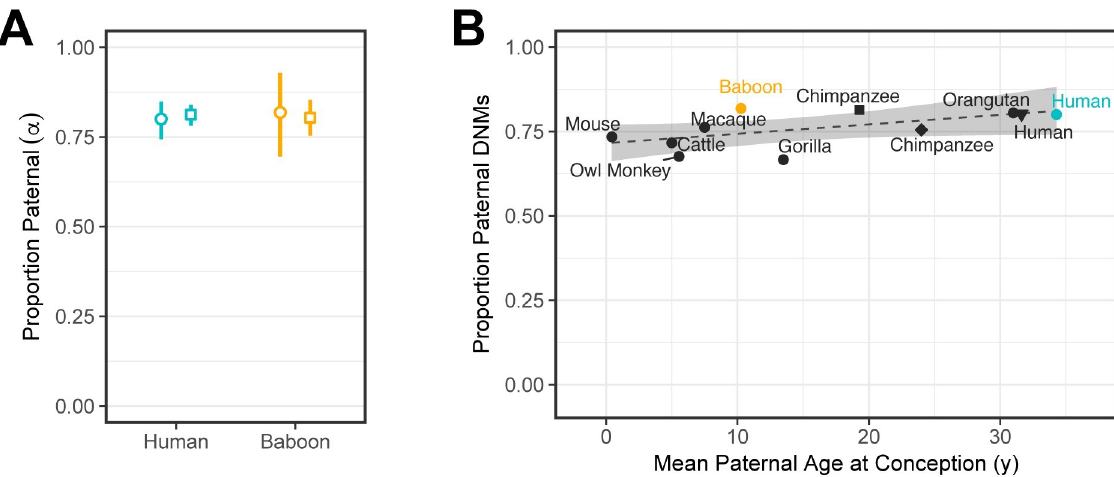
Fig 3. Estimates of the sex bias in mutation across mammals. (A) Ratio of paternal-to-maternal mutations, α , among phased DNMs. Circles indicate the fraction of DNMs assigned to the paternal genome among all transmitted DNMs (i.e., DNMs observed in an F2 offspring); in our samples, the mean ages in humans were 34.3 years for males and 31.3 years for females and in baboons, 10.3 years and 9.2 years, respectively (so the ratio of male-to-female generation time was about 1.1 in both). Vertical lines indicate 95% CIs, which were determined by bootstrap resampling of 50 cM blocks. Squares denote the ratio of paternal-to-maternal mutations estimated for typical parental ages in the species, assuming ages 32.0 and 28.2 years for human males and females, respectively, and 10.7 and 10.2 years for baboon males and females. Vertical lines denote the 95% CIs of the age effect and intercept estimates, obtained assuming normally distributed errors. (B) The ratio of paternal-to- maternal DNMs estimated from pedigrees across 9 mammalian species as a function of the mean male generation times in the study (for references, see Table 1). The square and diamond points denote separate chimpanzee estimates from Besenbacher and colleagues and Tatsumoto and colleagues, respectively [22,23]. The black triangle denotes the estimate for DNMs phased by transmission in 225 3-generation human pedigrees from Jo´nsson and colleagues [17]. Human and baboon estimates reported in this study are colored teal and orange, respectively. Fitting a linear regression (dashed line) yields an estimated slope of only 2.8 × 10 − 3 (95% CI − 9.2 × 10 − 4 to 6.5 × 10 − 3 , p - value = 0.12). To avoid duplicates, values from one chimpanzee (Tatsumoto and colleagues [23]) and one human (Jo´nsson and colleagues [17]) study were not included in the regression. The shaded area denotes the 95% CI of the slope and intercept. Underlying data for this figure can be found in S2 Data. cM, centimorgan; DNM, de novo mutation; SNP, single-nucleotide